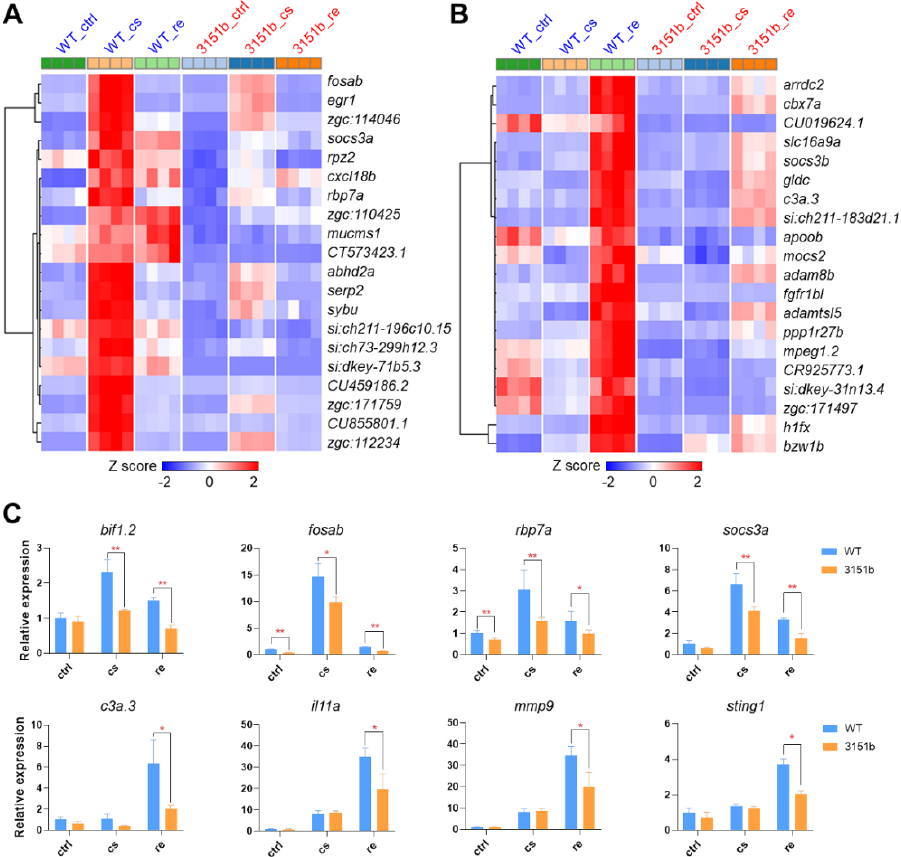
Figure 5. Representative genes affected by Tmem39b dysfunction upon cold exposure and rewarming. Heatmaps demonstrate expressions of the representative up-regulated genes upon cold exposure ( A ) and rewarming ( B ). The up-regulation of these genes is attenuated in the tmem39b mutants in comparison to the corresponding genes in WT. ( C ) Transcriptional expression of the representative genes determined using qPCR. *, p ≤ 0.05; **, p ≤ 0.01 ( n = 4).